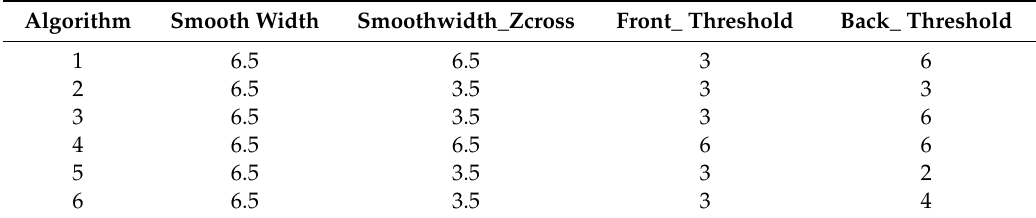
Figure 3. Example of a GEDI waveform acquired over a lake and corresponding waveform metrics; 1 ns corresponds to 15 cm sampling distance in the waveform. Table 2. The different parameters used in each of the six algorithms for the interpretation of the received waveforms.